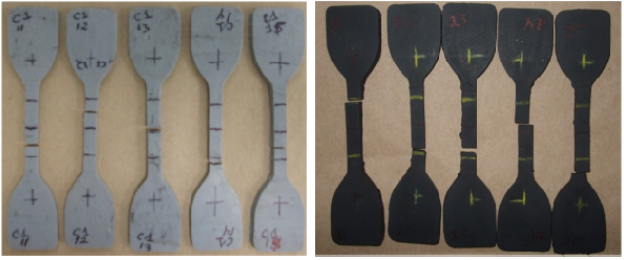
Figure 8. Specimens of PBR and PBR-CB subjected to uniaxial cyclic tension tests, according to ASTM D412 Rev A, standard die C.